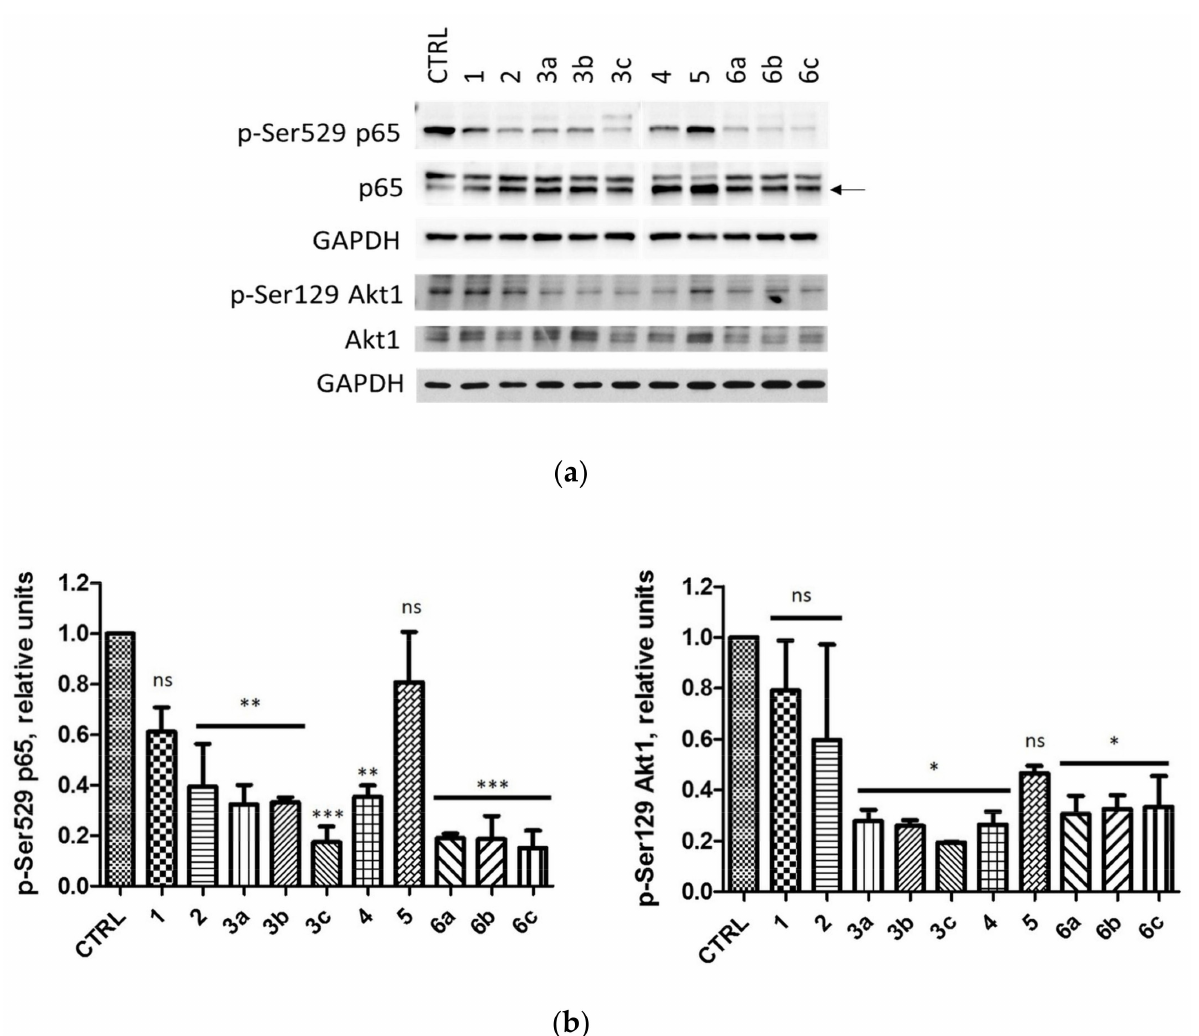
Figure 6. Effects of compounds 1 , 2 , 3a – c , 4 , 5 and 6a – c on the levels of p65 and Akt1 and their phosphorylated forms (p-Ser529 p65 and p-Ser129 Akt1, respectively) in MCF-7 cell line after 72-h treatment. ( a ) Western blot analysis of the following proteins in the extracts obtained from MCF-7 cells after 72-h treatment with the tested compounds used in the concentrations corresponding to their EC 50 values. GAPDH was used as a protein loading control for each sample. ( b ) Densitometry analysis for p-Ser529 p65 and p-Ser129 Akt1 was performed relative to untreated control (CTRL) cells. Graphs represent mean values ± s.e.m. * p < 0.05, ** p < 0.01, *** p < 0.001 relative to control; ns—not